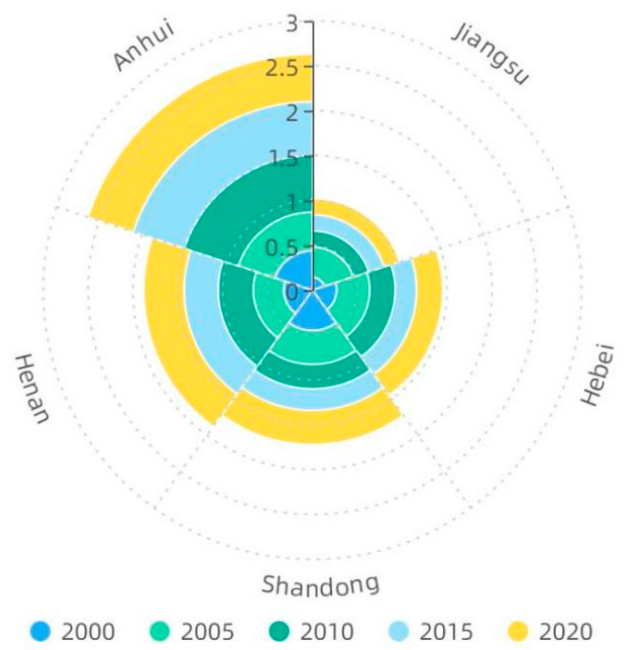
Figure 5. The change of the Gini coefficient between cultivated land resources and the water resources for agriculture.